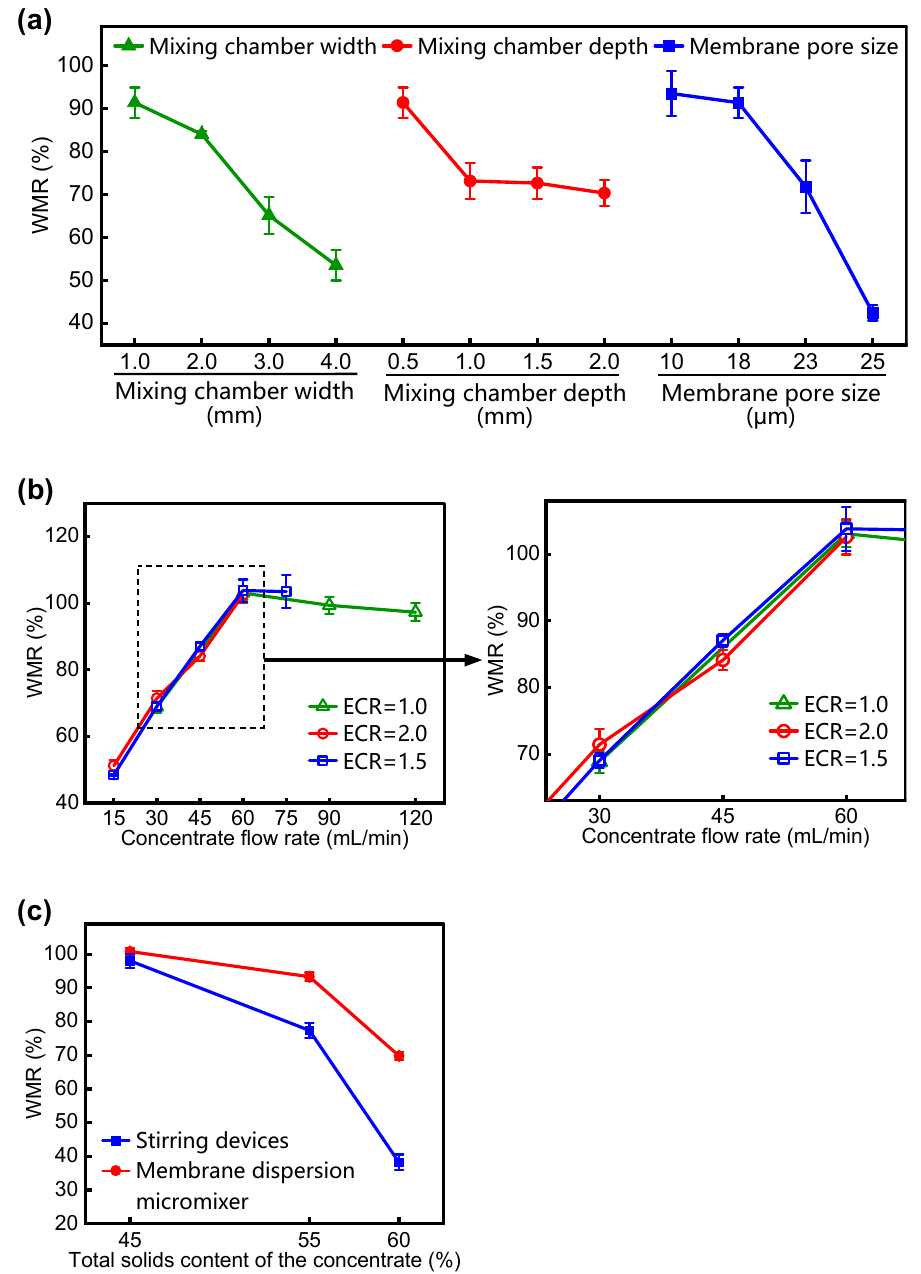
Figure 9. WMR values under different membrane pore size, mixing chamber width, mixing chamber depth ( a ), concentrate flow rate, ECR ( b ), and total solid content of the concentrate ( c ) on a membrane dispersion micromixer. The results are expressed as mean ± standard deviations, n = 3.